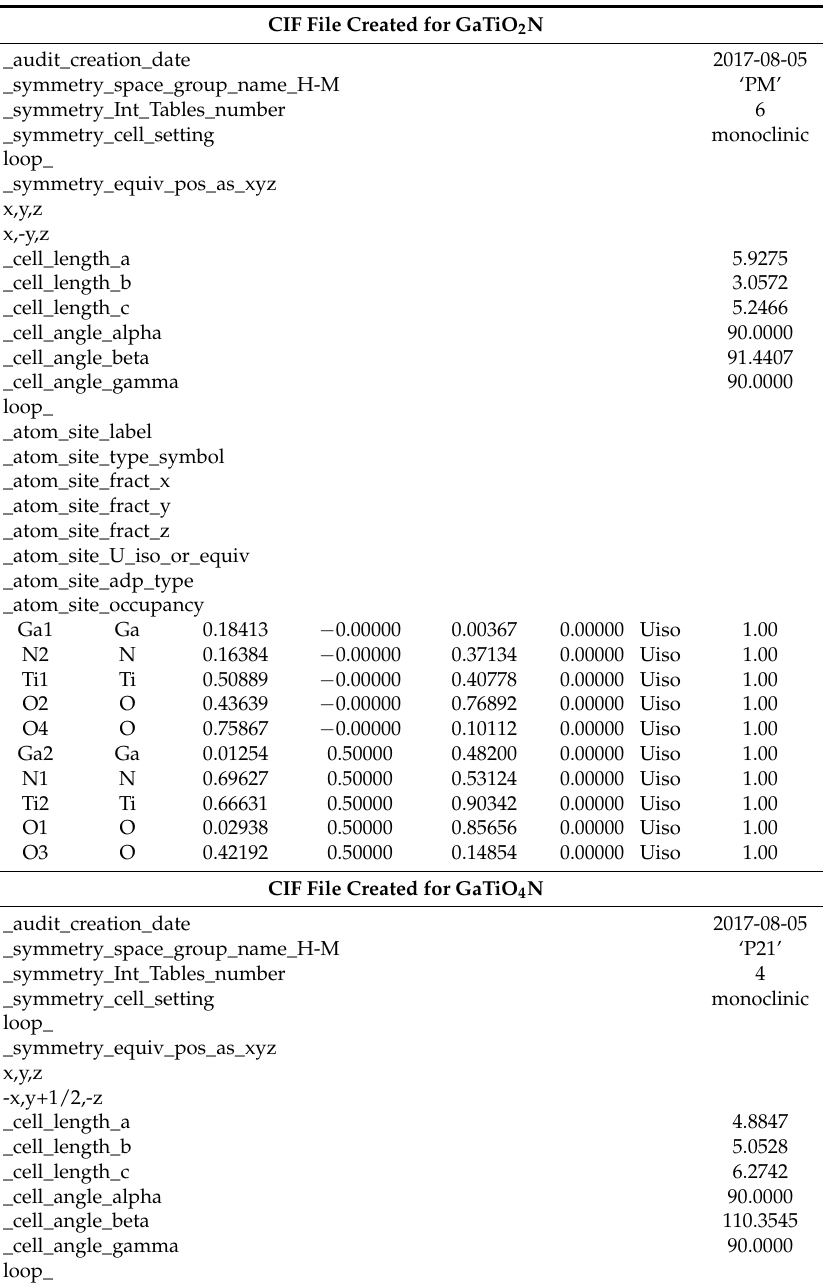
Table A4. Crystallographic Information Files (CIFs) created for GaTiO 2 N and GaTiO 4